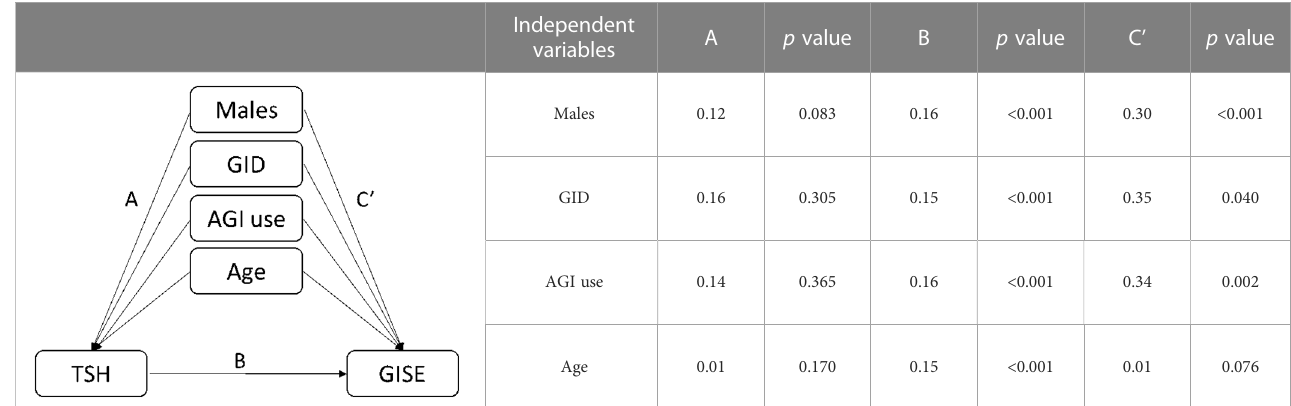
TABLE 2 Models of the mediating effects of TSH on the association between independent variables and